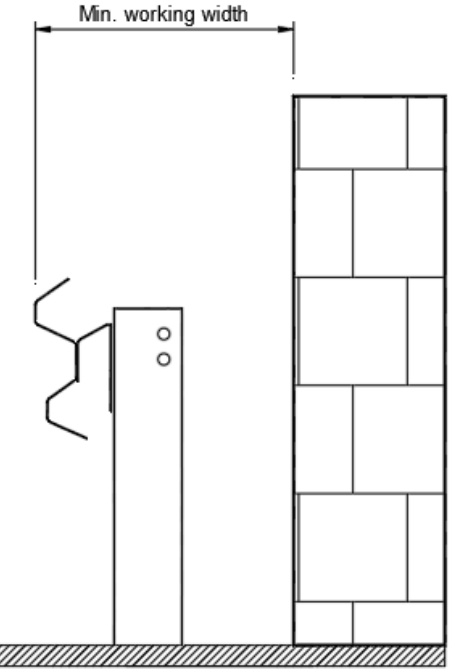
Figure 3 . Minimum working width between face of the guardrail and protected